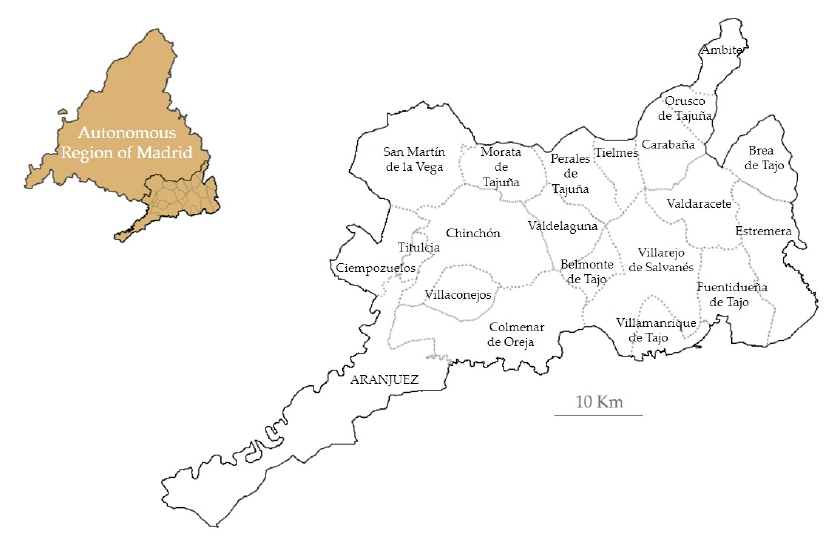
Figure 1. The study area.